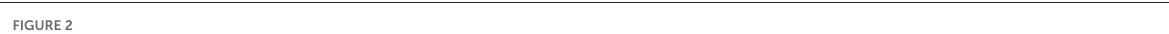
FIGURE2 amphibian roadkill observations showing the spatial sampling intensity across R Korea. (D) A kernel density map of the iNaturalist reptile roadkill observations showing the spatial sampling intensity across R Korea. The spatial bias of roadkill observations is apparent from the cluster of records in the northern and western portions and the relative paucity of observations in the southeastern region of R Korea. (E) Spatial bias of the regional representation of herpetofauna roadkills based on the available literature. The unit of spatial bias (count) is a simple count of the general region surveyed (refer to Section Materials and methods for details). (F) The location of the study area (R Korea) in northeast Asia highlighted in blue. The map was generated in QGIS 3 with the elevation raster downloaded from the WorldClim database (Fick and Hijmans, 2017) as a base map for (A,B) . Darker coloration in the base map (green shade) indicates higher elevation, whereas lighter coloration (yellow shade) indicates lower elevation.